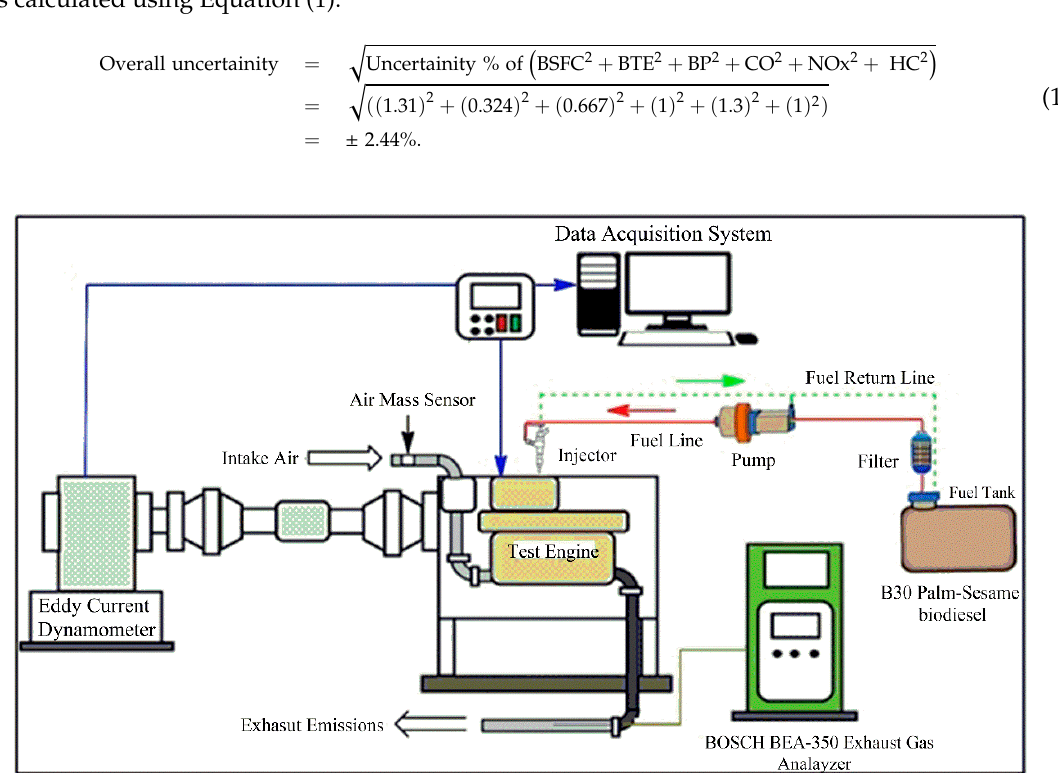
Figure 2. Schematic view of diesel engine set-up.